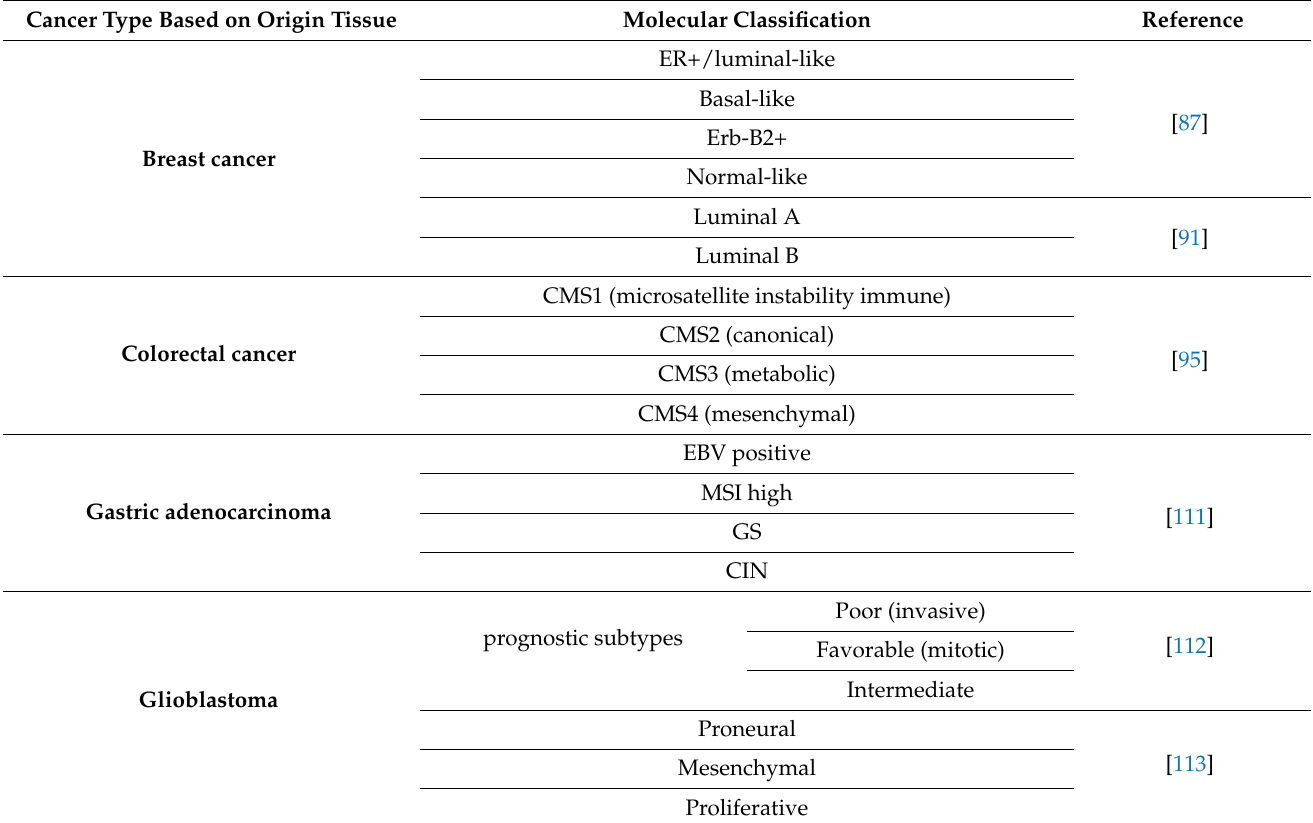
Table 1. Examples of transcriptome-based molecular classification of particular malignancies. Cancer Type Based on Origin